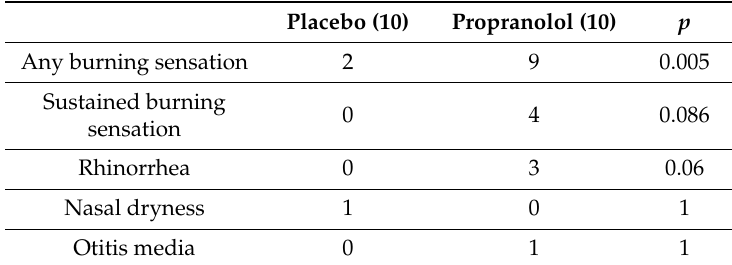
Table 5. Side e ff ects of the double-blind